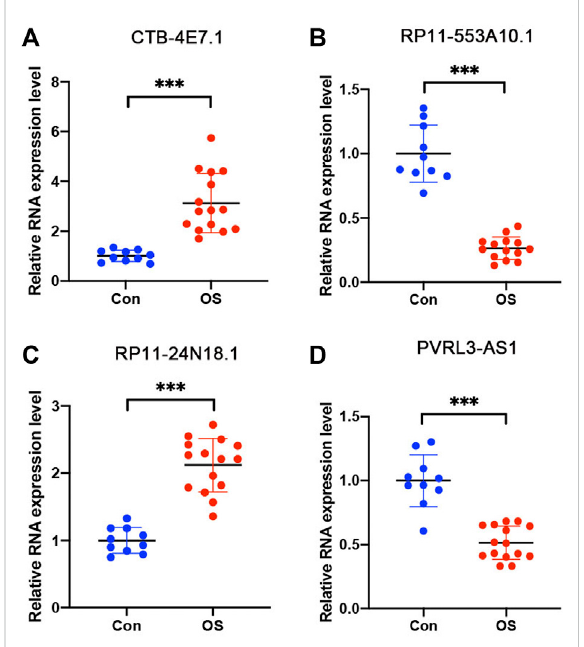
FIGURE 8 Expression level of the four lncRNAs validated by RT-qPCR in osteosarcoma cells. (A) CTB-4E7.1; (B) RP11-553A10.1; (C) RP11- 24N18.1; and (D) PVRL3-AS1. HSMC, human skeletal muscle cell; OS cells, osteosarcoma cells. Data are mean ± SD ( n = 3 biologically independent samples). * p < 0.05, ** p < 0.01, *** p < 0.001 (Student ’ s t